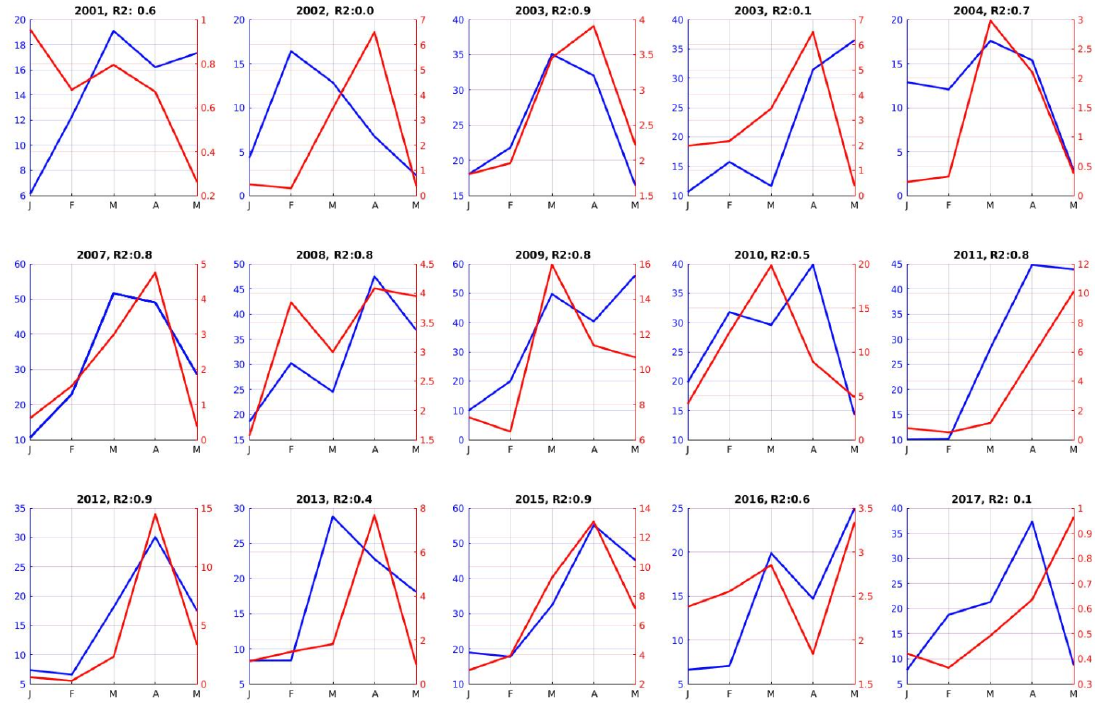
Figure 8. Time series of the monthly simulated runoff in m 3 /s ( blue ) and observed discharge in m 3 /s ( red ) at Aghbalou between January and May from 2000–2017.